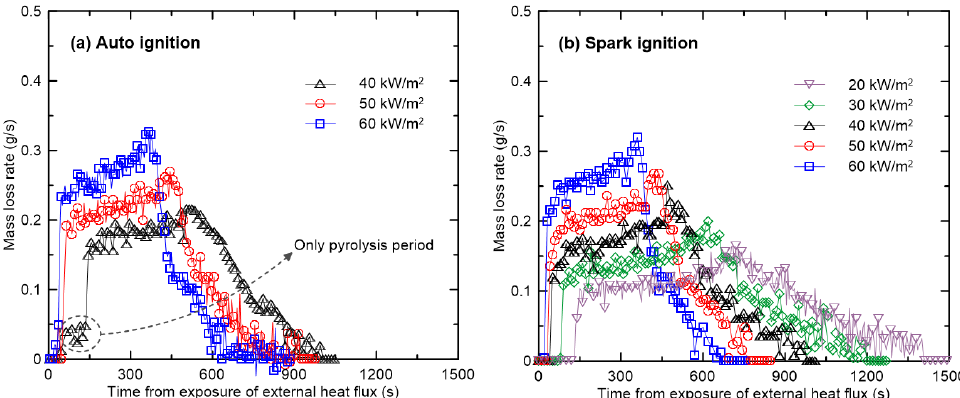
Figure 4. Time histories of mass loss rate under the conditions of various external heat fluxes for the auto and spark ignitions.